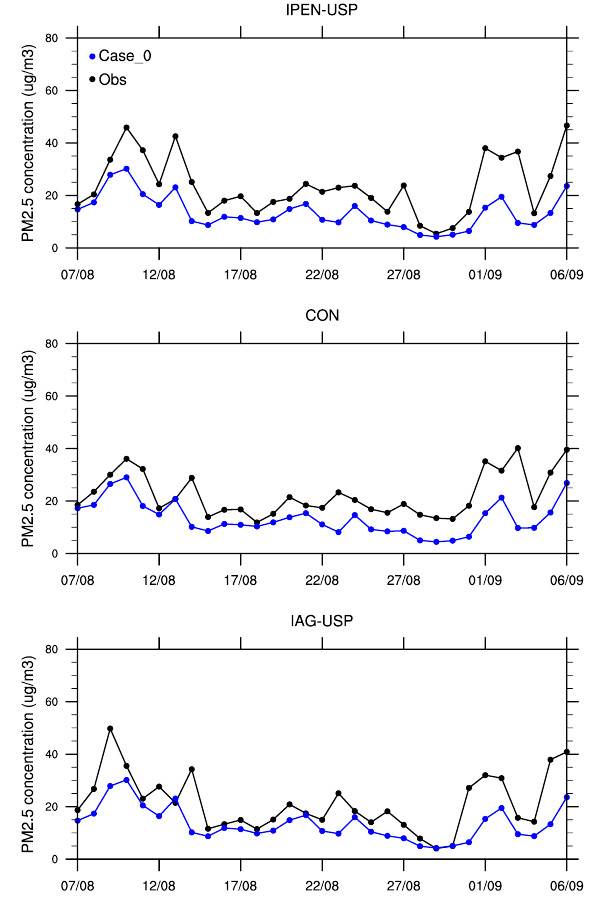
Figure 7. The observed and predicted daily variations of PM 2 . 5 concentrations at three sites in SPMA for the 3km modelling do-